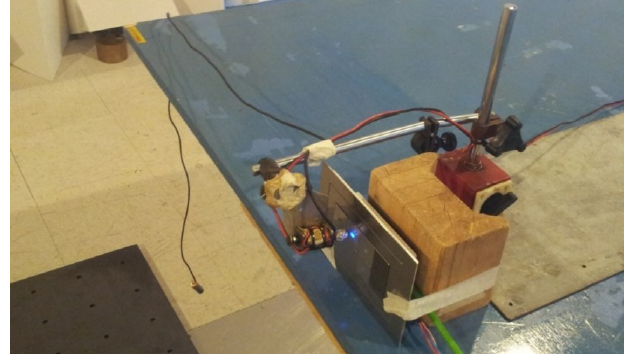
Fig. 14. Electromagnetic actuation system for mimicking the touch on the metal switch with an aluminum rounded tip connected to a 1.5 V battery for the electrostatic stimulus. The assembly was installed in the anechoic chamber during EMC